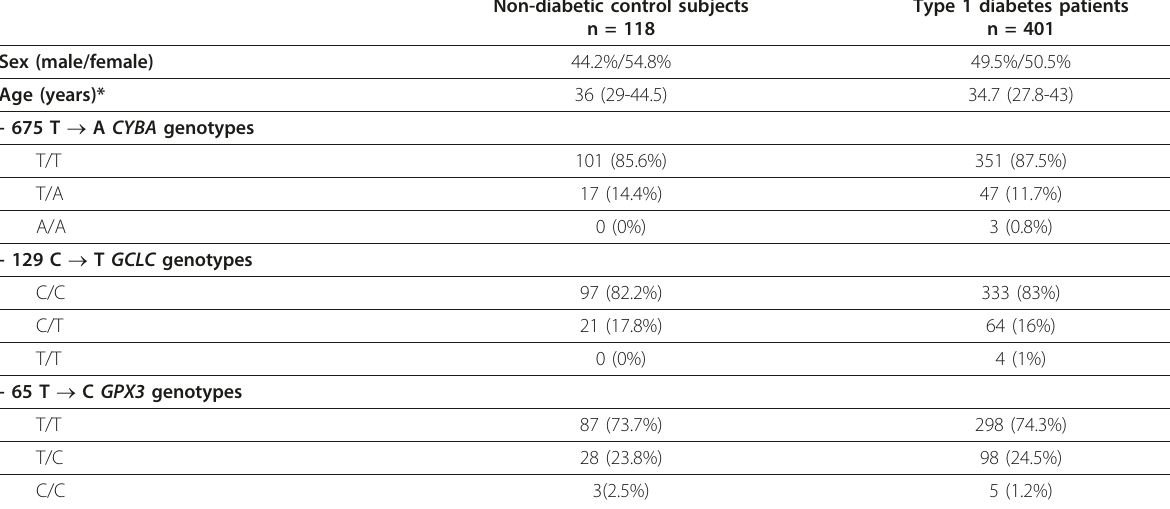
Table 1 Frequency of CYBA - 657 T ® A (unregistered), GCLC - 129 C ® T (rs17883901) and GPX3 - 65 T ® C (rs8177412) polymorphisms in type 1 diabetes patients and non-diabetic control